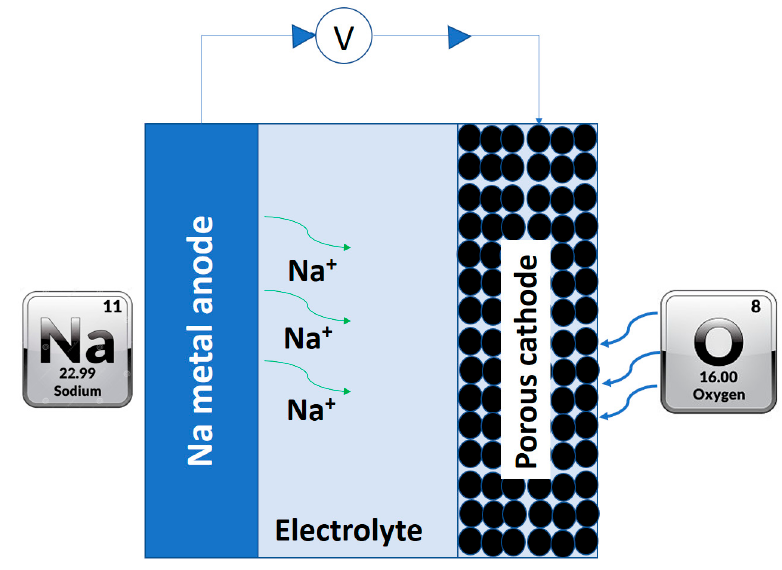
Figure 5. Schematic representation of a typical sodium-air battery.